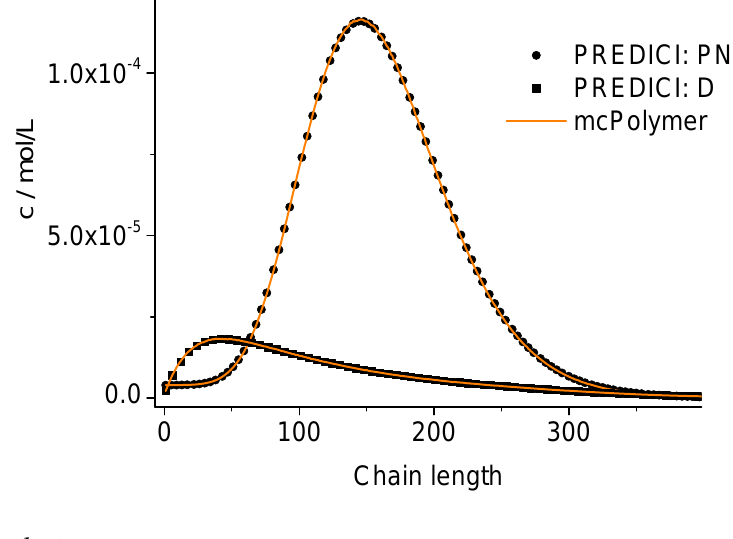
Figure 6. Chain length distributions compared to PREDICI simulation